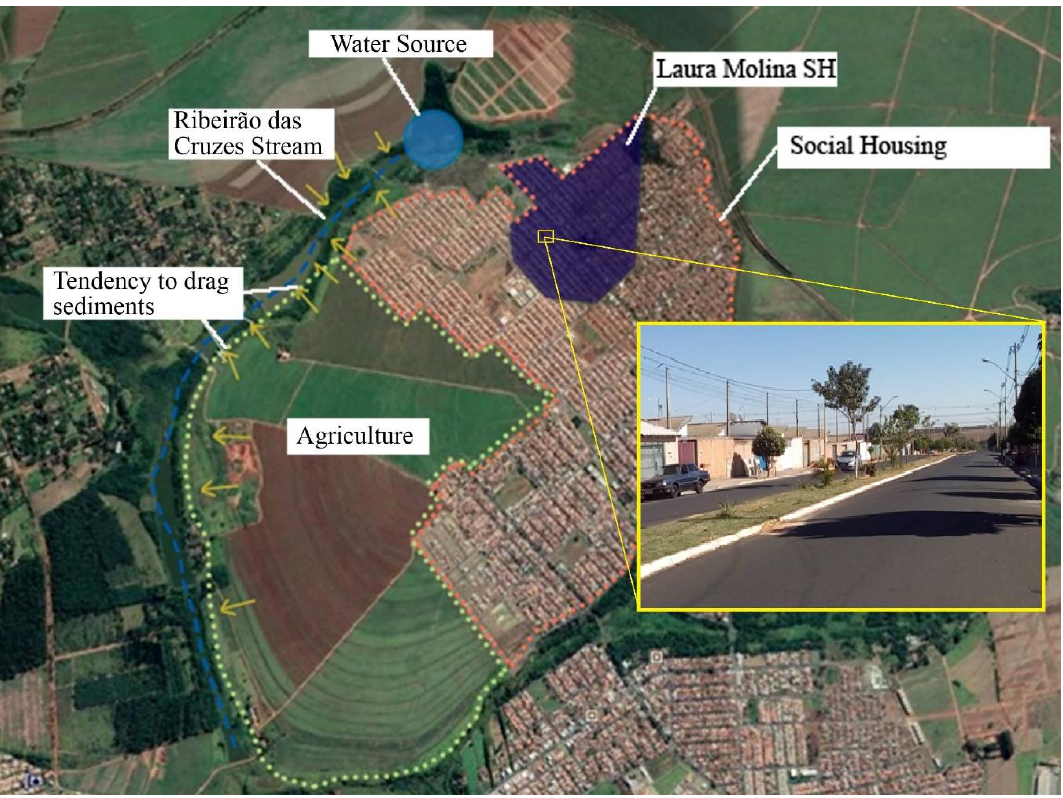
Figure 2. Araraquara north area. Source: Adapted from [25,27] .